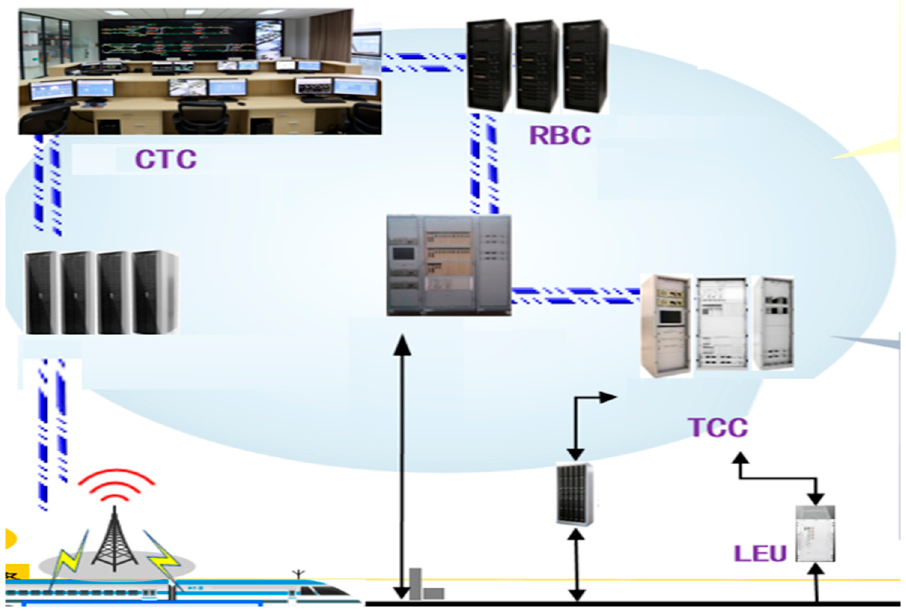
Figure 3. CTCS 3 architecture diagram.